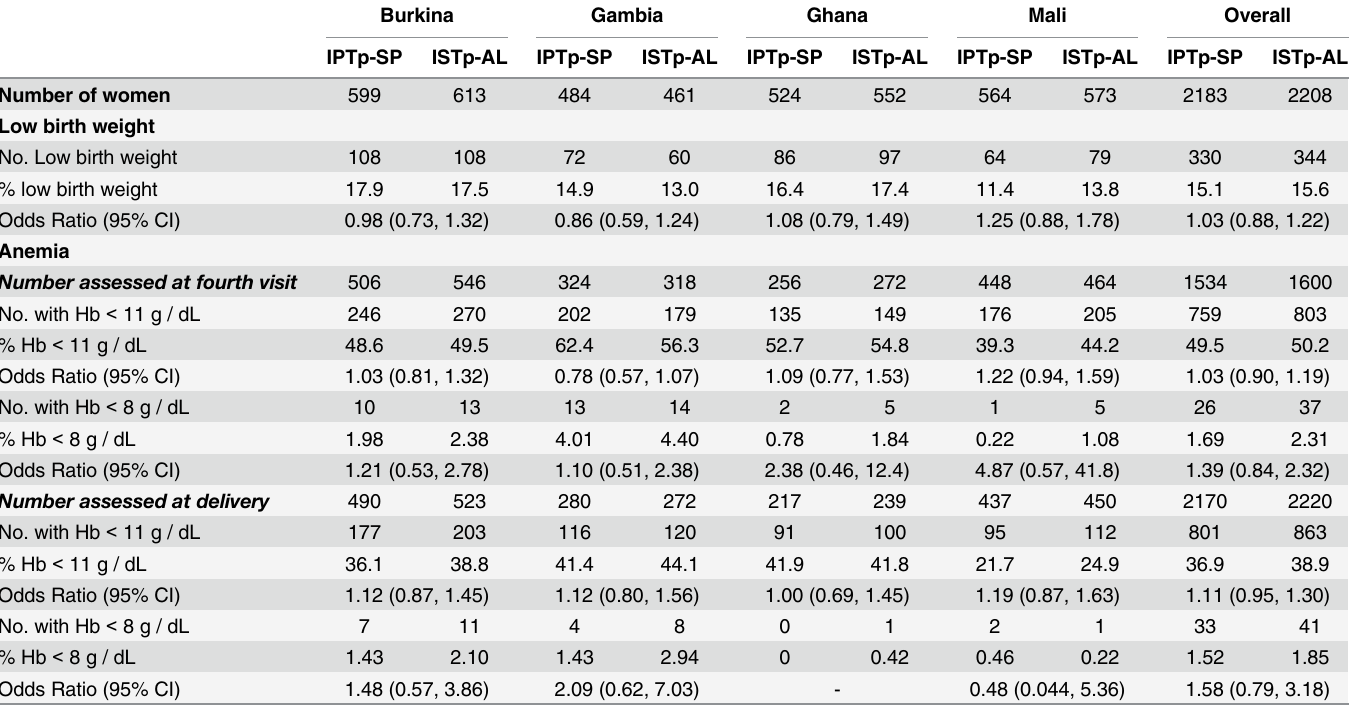
Table 2. Risk of low birth weight and anemia by intervention